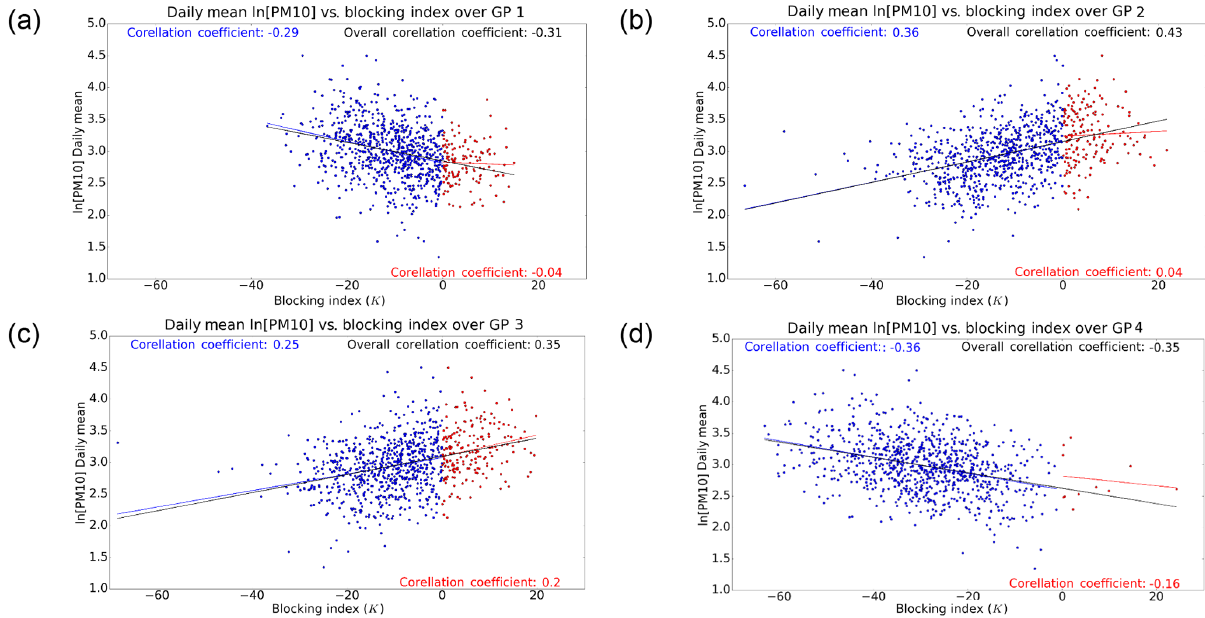
Figure 2. Scatter plots illustrating the relationship between blocking index magnitude (BI) (K) and UK [PM 10 ] (µg − 3 ) for four regions, labelled GP 1, 2, 3 and 4 in Fig. 1 (labelled (a) , (b) , (c) and (d) in Fig. 2). The blue and red colour corresponds to negative and positive BI values respectively, and the fitted trends are linear least-squares trends. Data were obtained for DJF January 1999–December 2008, and [PM 10 ] lagged by 1 and 0 days for positive and negative BI values